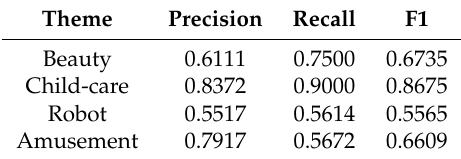
Table 6. Precision, recall, and F1 with hyperparameters in our previous study